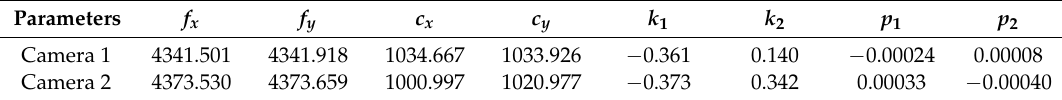
Table 1. Calibration results.